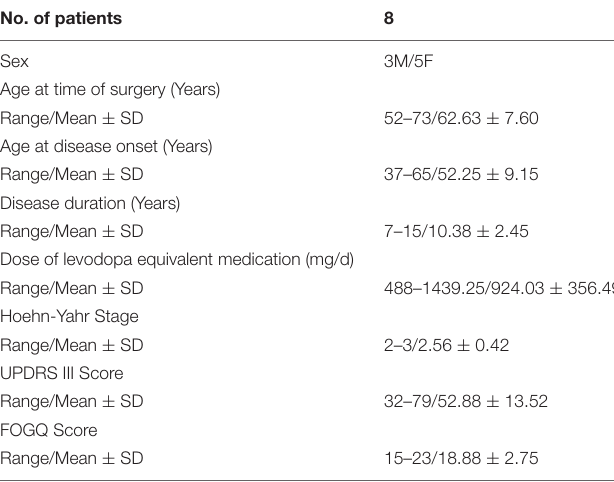
TABLE 1 | Preoperative characteristics of the eight